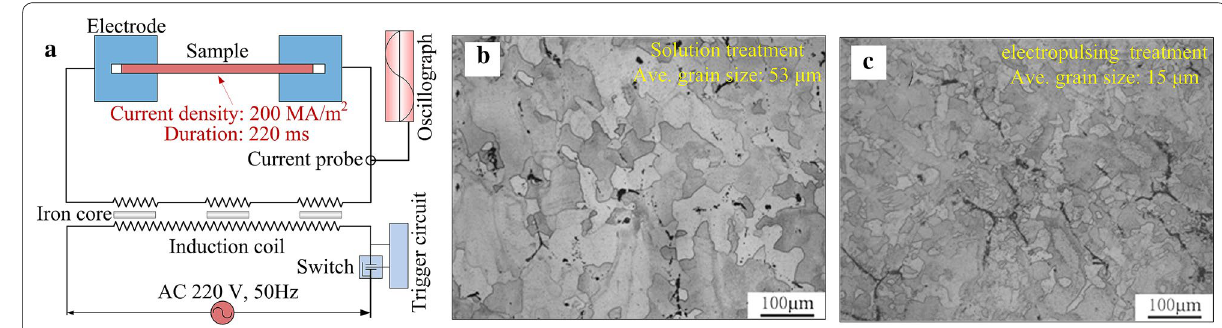
Figure 13 Electropulsing treatment method and result: a schematic illustration for the electropulsing system (Redraw based on Ref. [101]), b microstructure after conventional solution treatment, and c electropulsing treatment (Reproduced from Ref. [100])